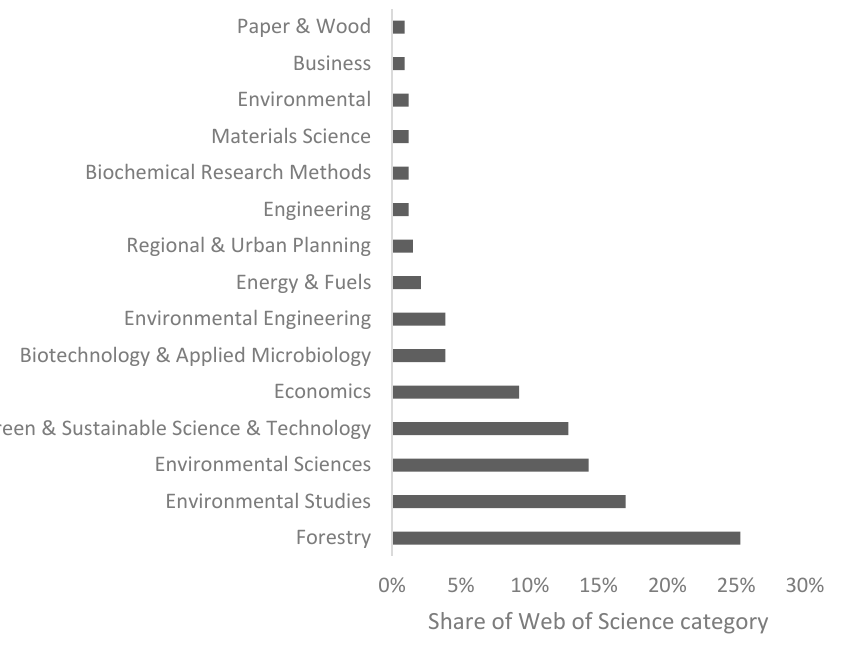
Figure 2. Share of papers published in journals listed in Web of Science categories; 15 most prominent categories listed.